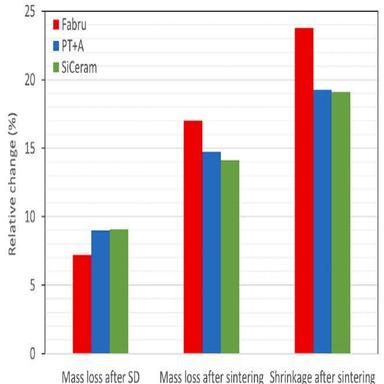
Mass loss and shrinkage analysis of the three different YSZ filaments (SiCeram, PT+A, and Fabru). The mass loss after solvent debinding (SD), after sintering as well as the diameter shrinkage after sintering was investigated.